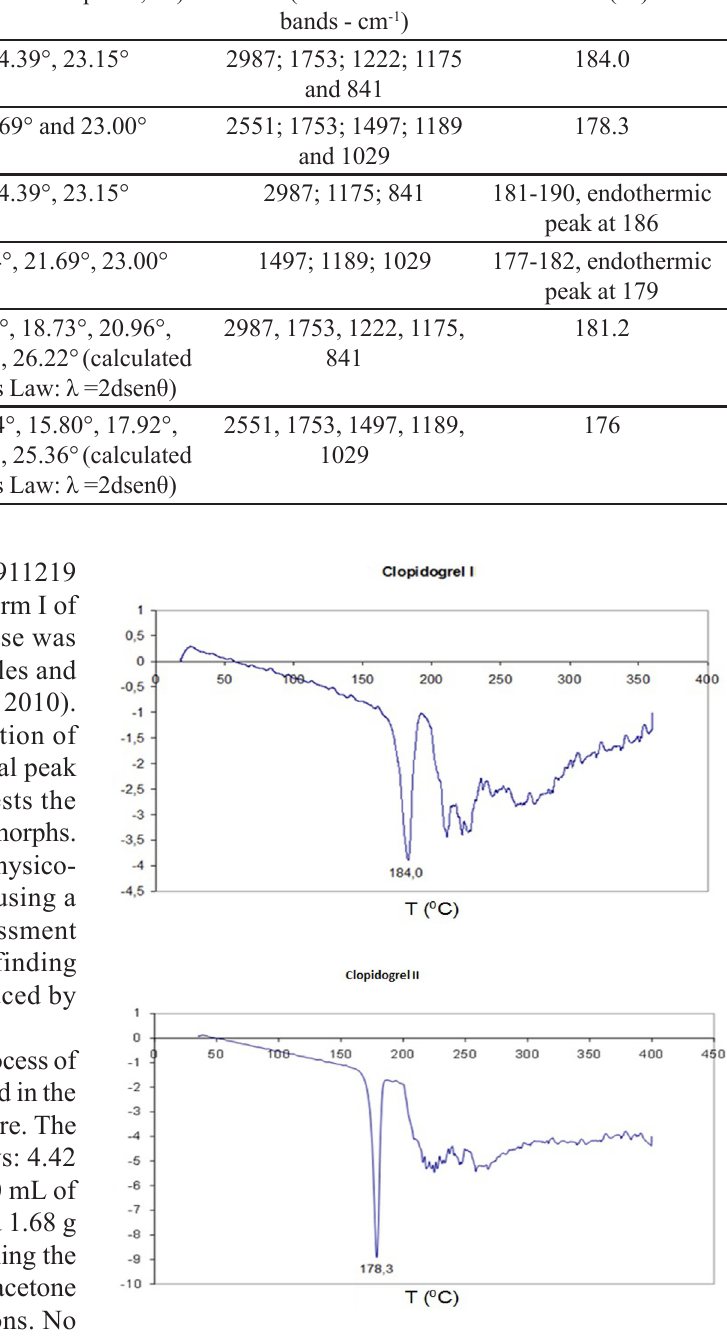
FIGURE 6 – DSC thermograms for forms I (top) and II (bottom) of clopidogrel